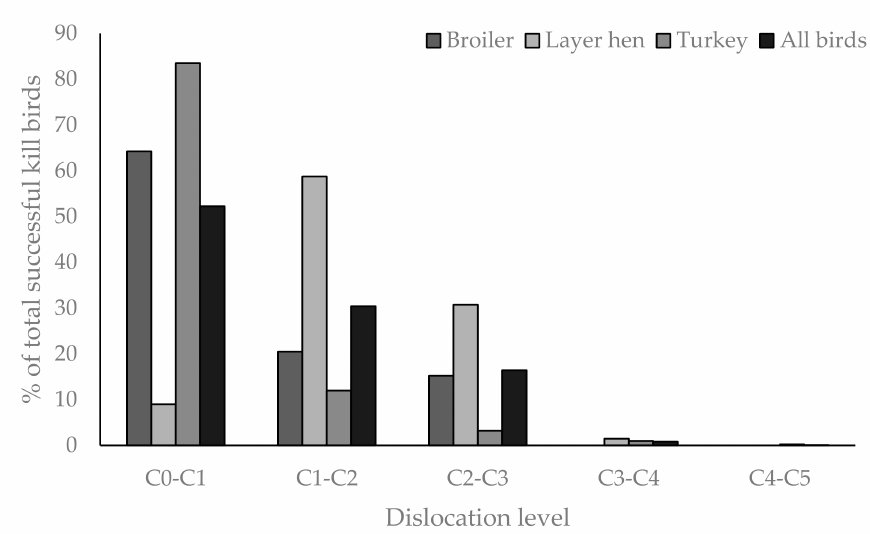
Figure 3. Bar chart showing the range of cervical dislocation levels achieved in successfully killed birds by cervical dislocation across all stockworkers, described as the proportion of birds (%) dependent on bird type ( p < 0.0001).